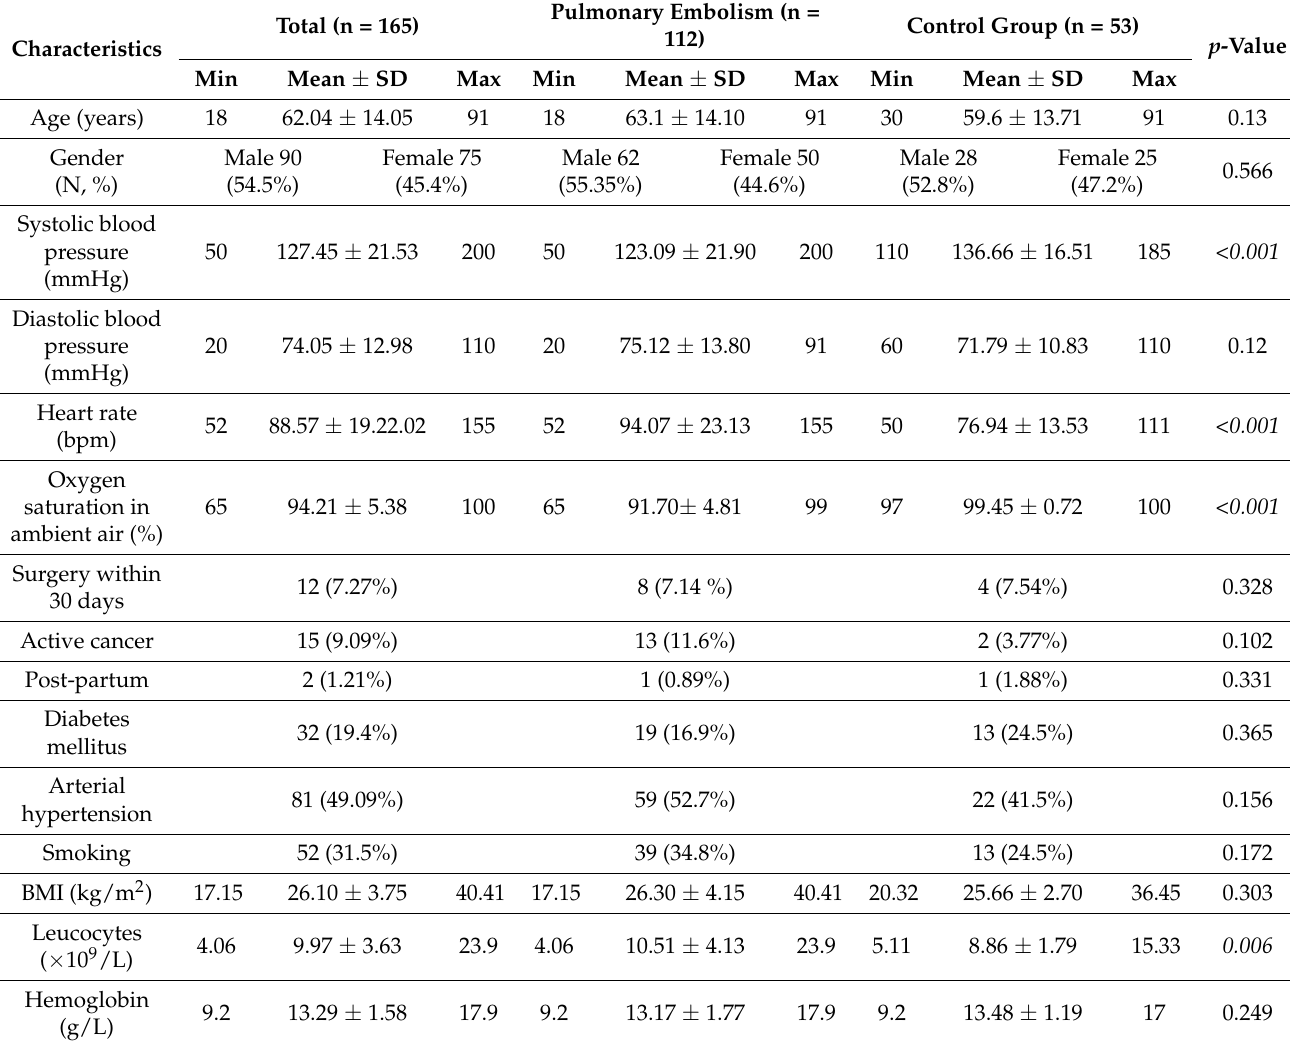
Table 1. General characteristics of the study